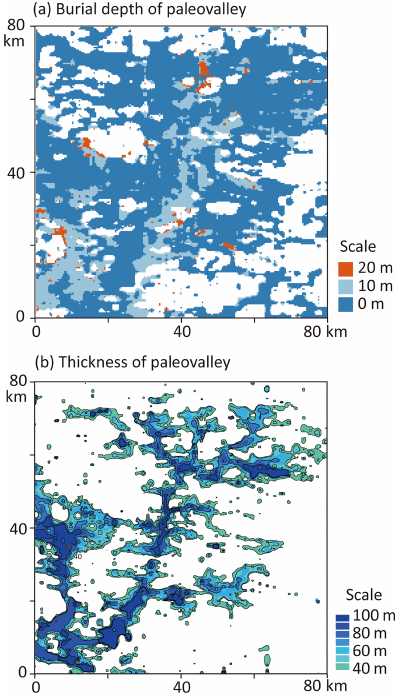
Figure 11. (a) Burial depth and thickness ( > 40m) of the allu- vium sediments in paleovalleys inferred from the 3-D binary val- ley image of Fig. 9c with a 10m vertical resolution. The hollow zone in (a) represents no identified paleovalleys within the depth of 100m in the study